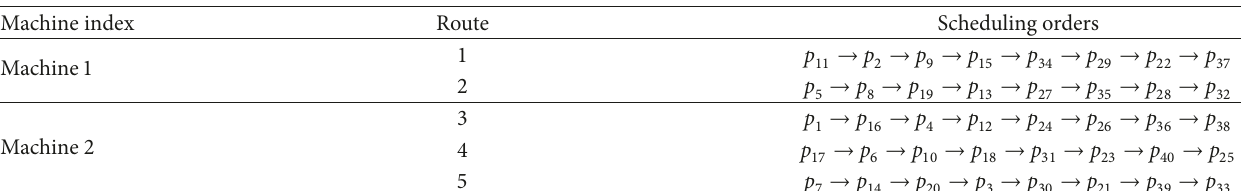
Table 6: Scheduling orders as optimized by multipopulation SaDE. “Machine” denotes the machine number index, “Route” denotes the route number index, and “Scheduling orders” denote the scheduling orders that one machine implements in one route.